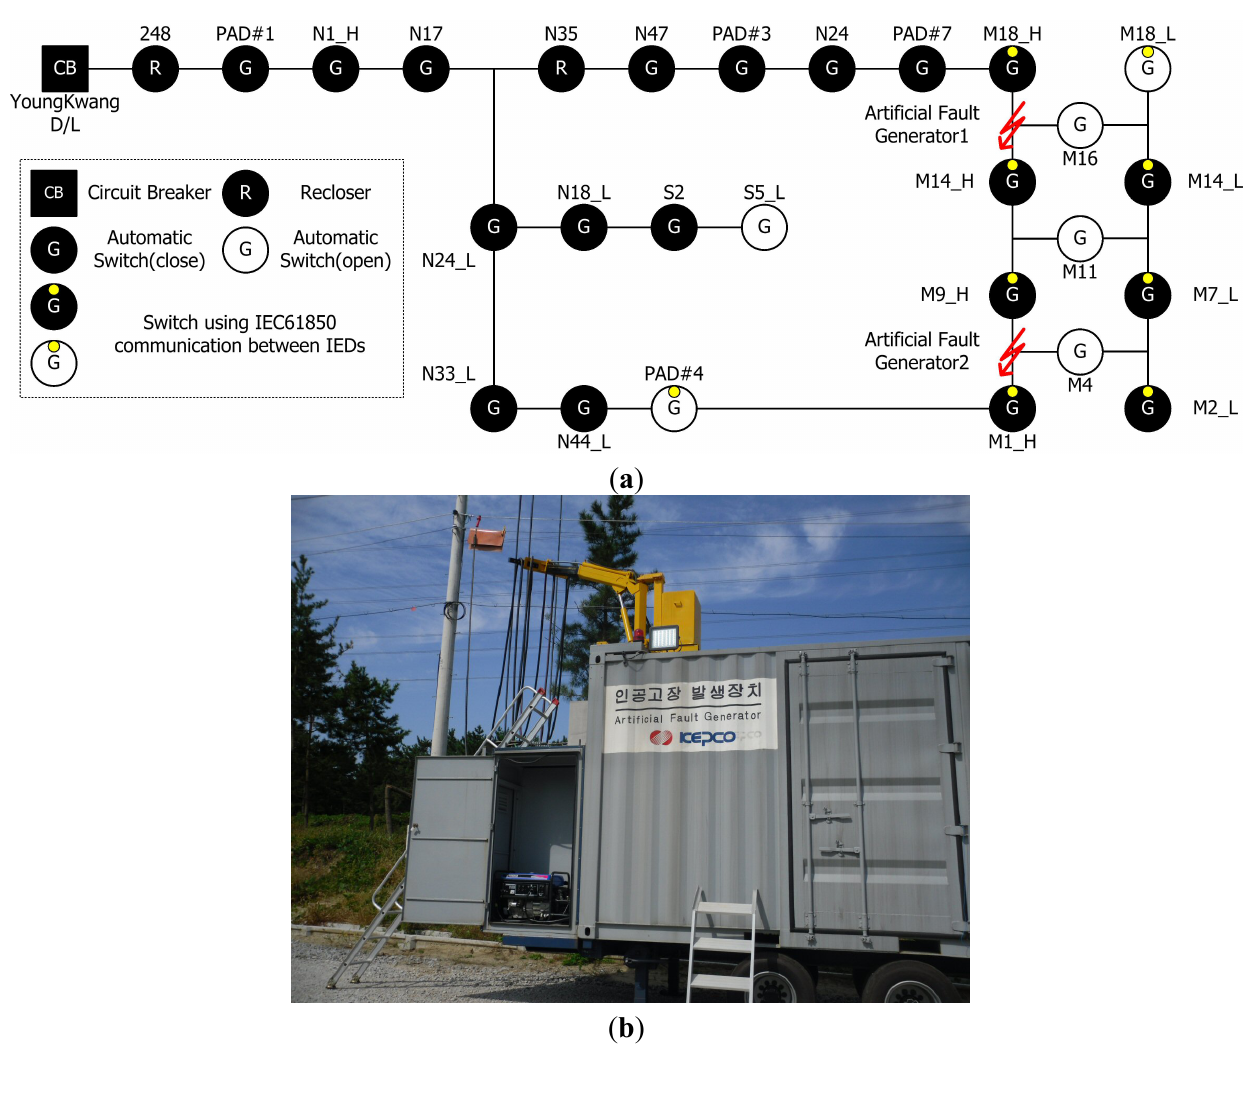
Figure 14. Gochang PTC field test: ( a ) one-line diagram of test network and ( b ) artificial fault